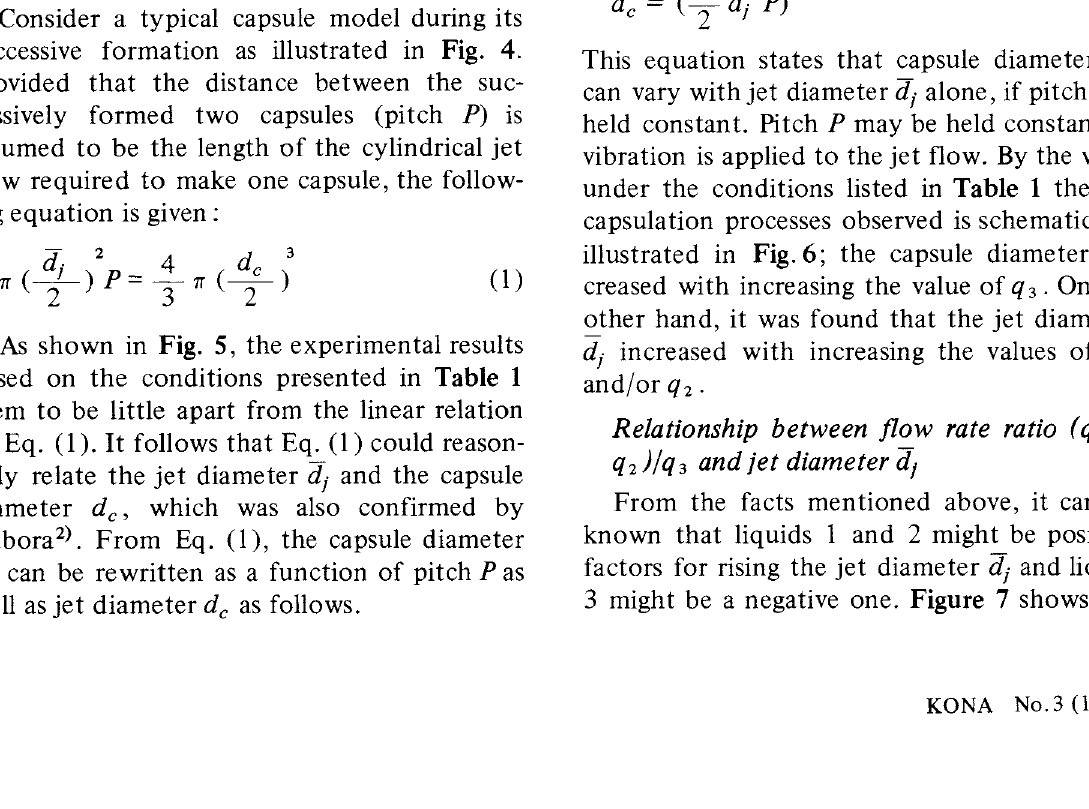
4.0 Fig. 5 Correlation of capsule volume and jet